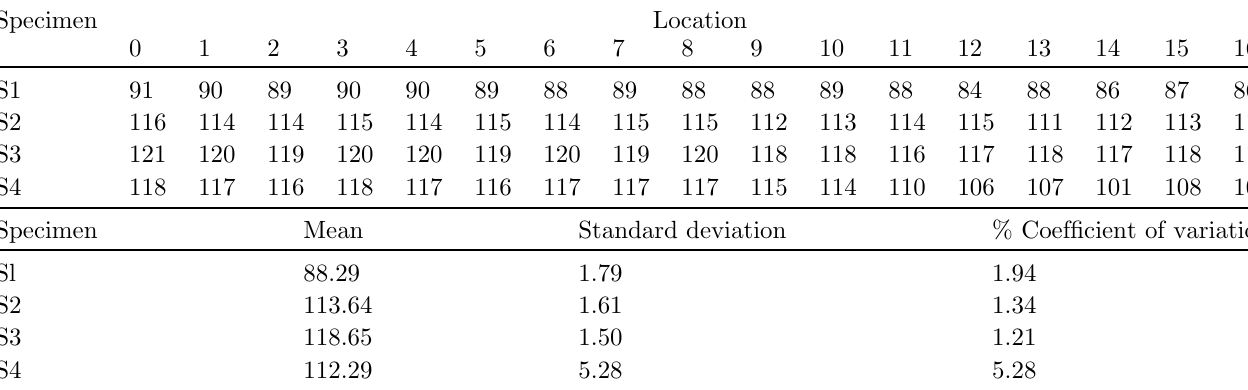
Table 5. Results of Minitab software tool.